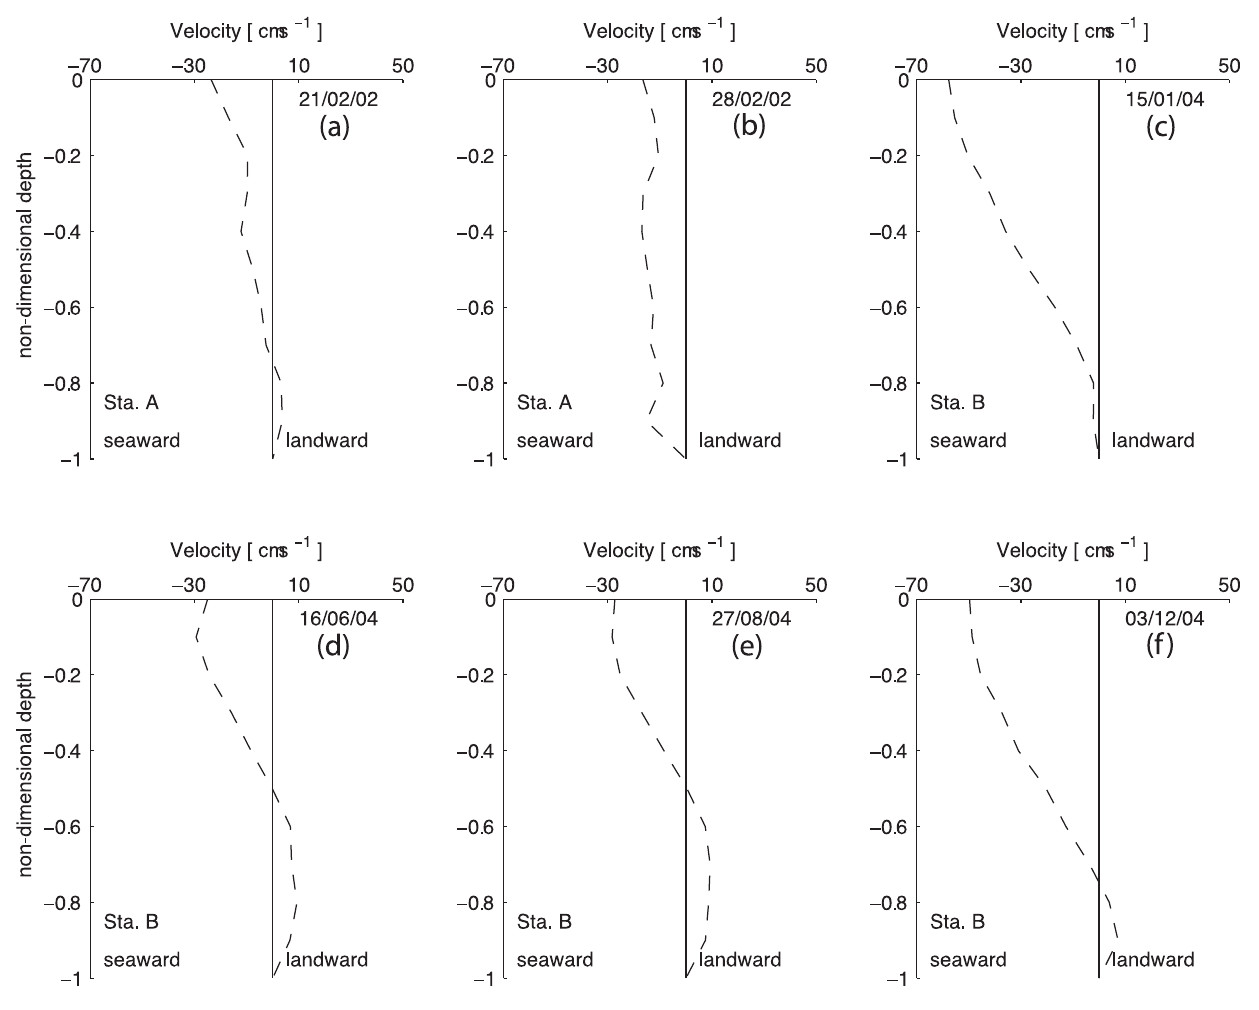
Figure 5. Profiles of non-tidal velocity at stations A and B.